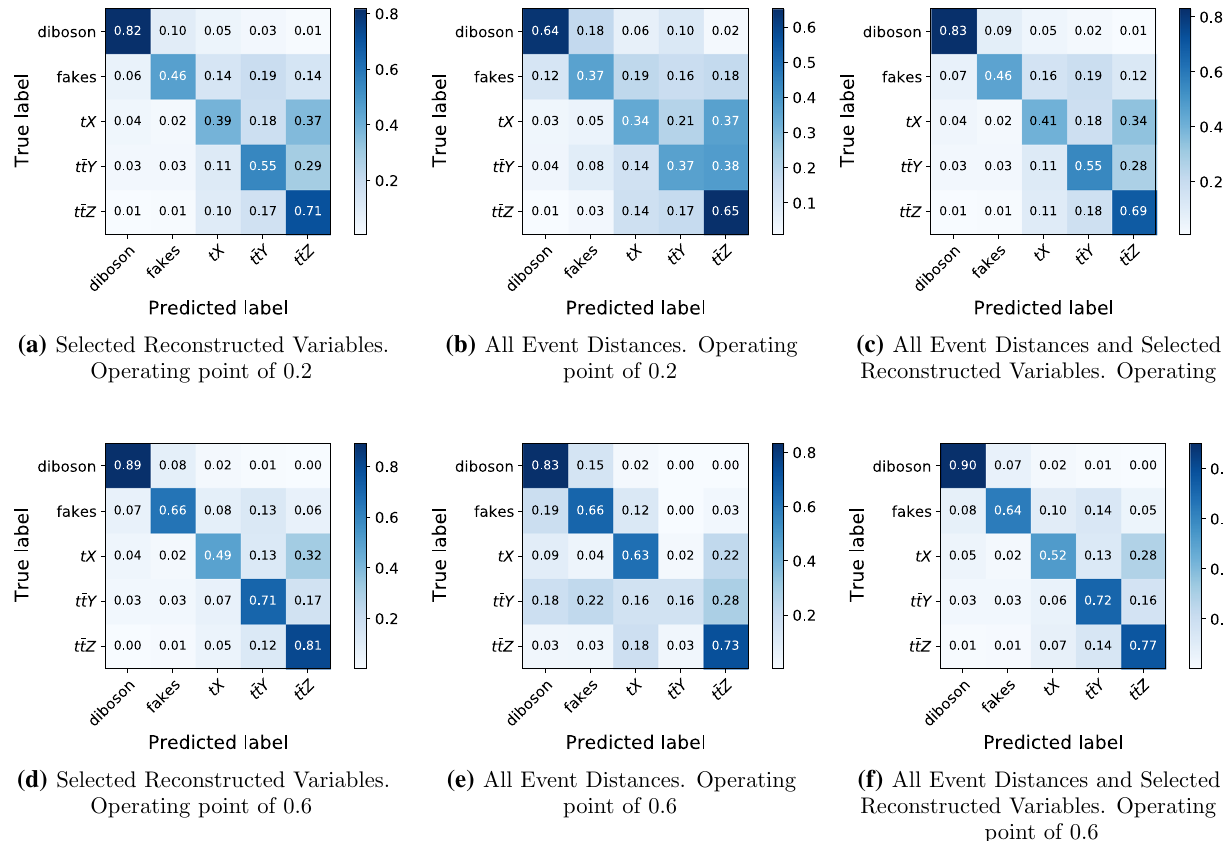
Fig. 6 Normalised confusion matrices for all DNN, depending on the trained features